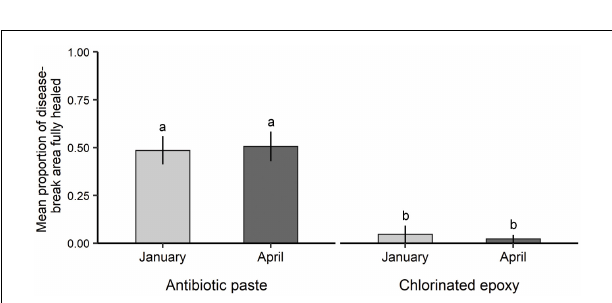
FIGURE 5 | The mean proportion of disease-break area that was fully healed by antibiotic paste and chlorinated epoxy treatments in both months visited. The letters above the bars indicate statistical differences between treatment materials during both months visited. Error bars = standard